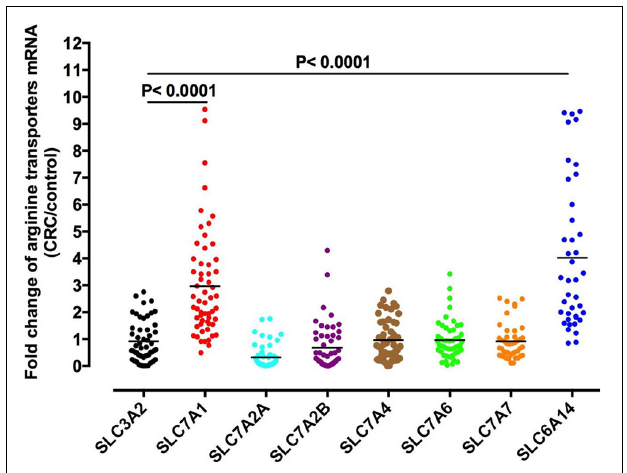
FIGURE 2 | Arginine transporters expression in colorectal cancer. The mRNA levels for each arginine transporter in colorectal cancer and adjacent normal tissues of 90 colorectal cancer patients were measured by qPCR. The expression of SLC7A1 and SLC6A14 genes were significantly upregulated in colorectal cancer